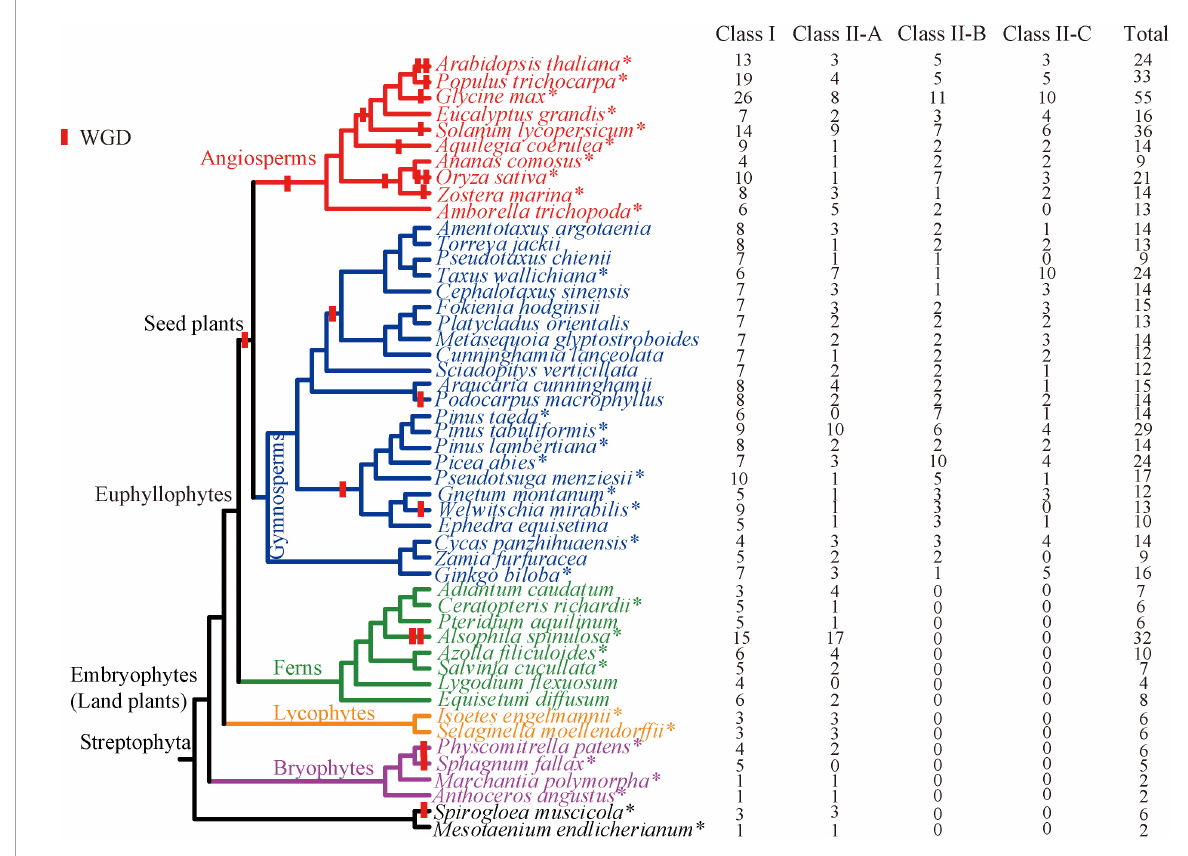
FIGURE1 Copy number of the TCP gene family for all investigated species in this study. Species with whole genome sequences are represented by asterisks. The overall topology of these species is based on One Thousand Plant Transcriptomes Initiative (2019), decorated with whole-genome duplication events (Rensing et al., 2007, 2008; Jiao et al., 2011; Li et al., 2015; Ren et al., 2018; Cheng et al., 2019; Stull et al., 2021; Huang et al.,